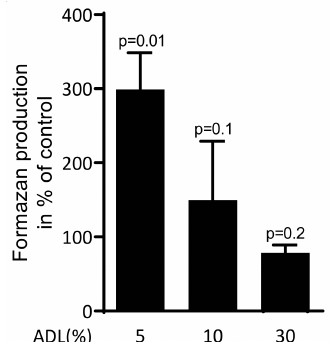
Figure 1. Acid dentine lysates (ADL) maintain viability of RAW 264.7 cells.